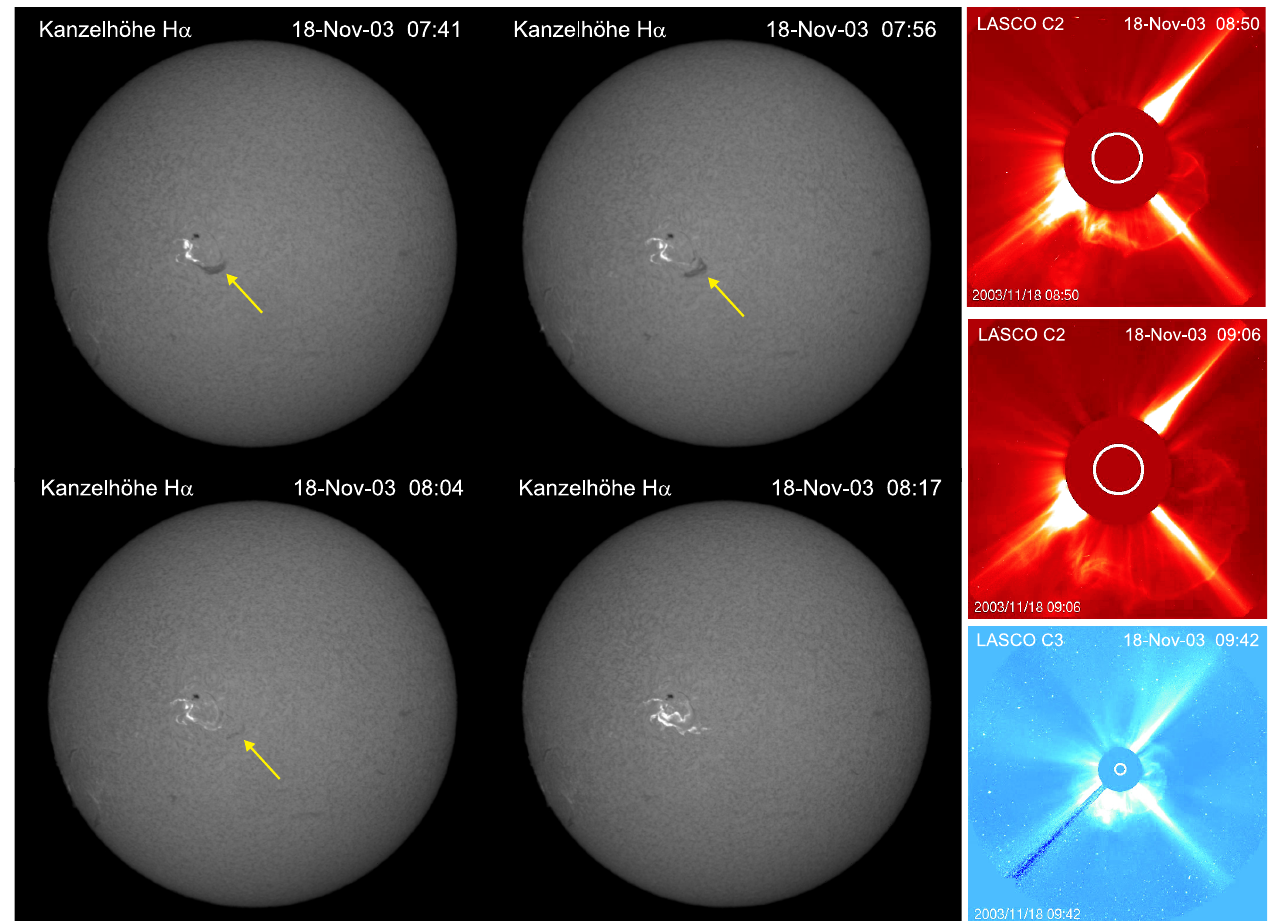
Fig. 1. Left 4 panels: H α filtergrams from the Kanzelh¨ohe Solar Observatory (Austria) showing the global flare evolution and the erupting filament (indicated by arrows). Right 3 panels: Temporal evolution of the associated CME in SOHO/LASCO C2 and C3.